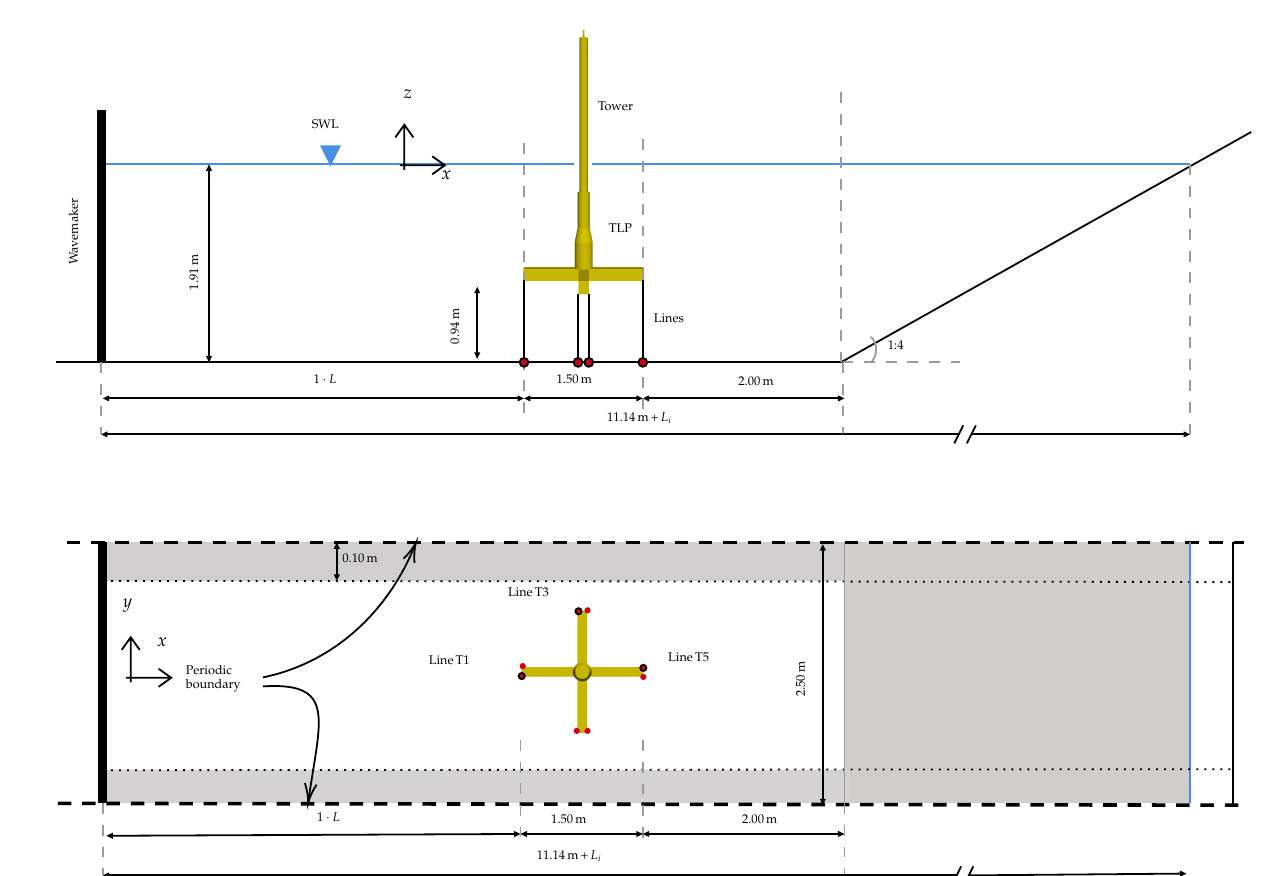
Figure 2. Schematic of the wave tank and TLP wind turbine dimensions in model scale. Note that L i , wave lenght, varies according to the considered wave condition, as defined in the text. The positions of the three mooring lines used in the following analyses are indicated with black and red dots, whereas the remaining lines (eight in total) are indicated with red